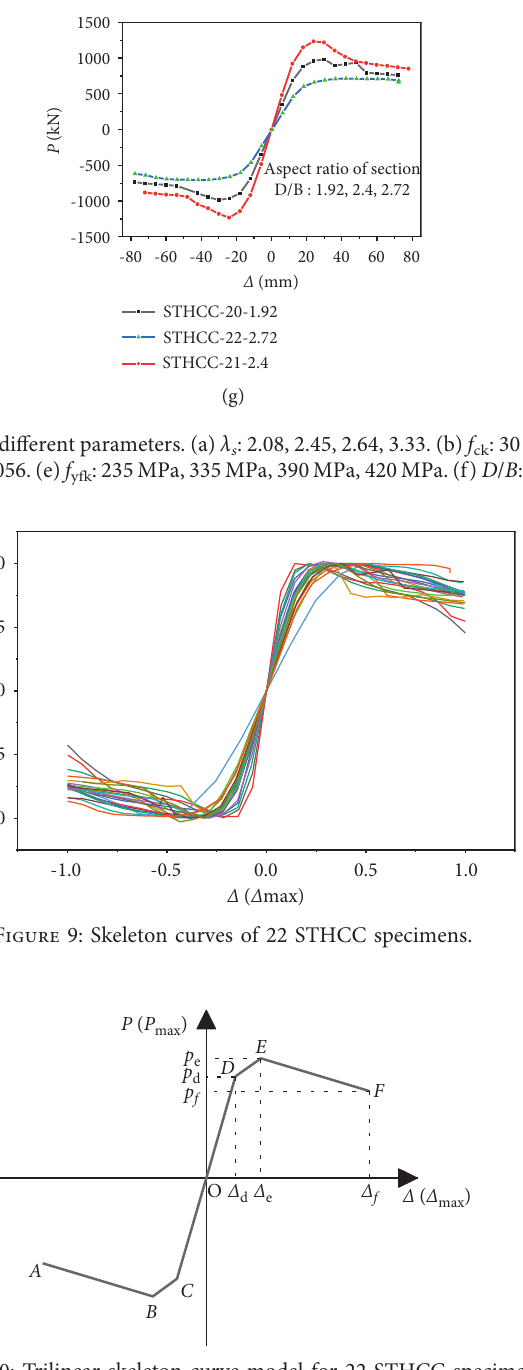
Figure 10: Trilinear skeleton curve model for 22 STHCC